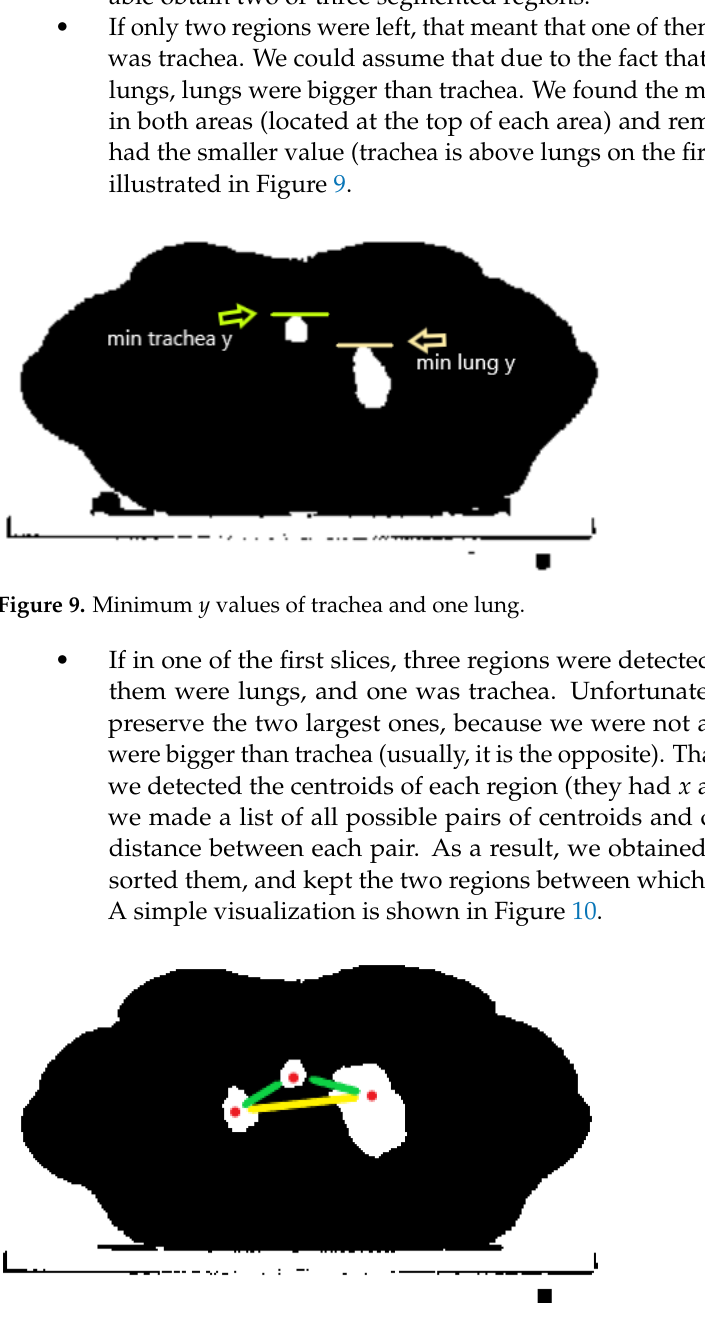
Figure 10. Distances between centroids